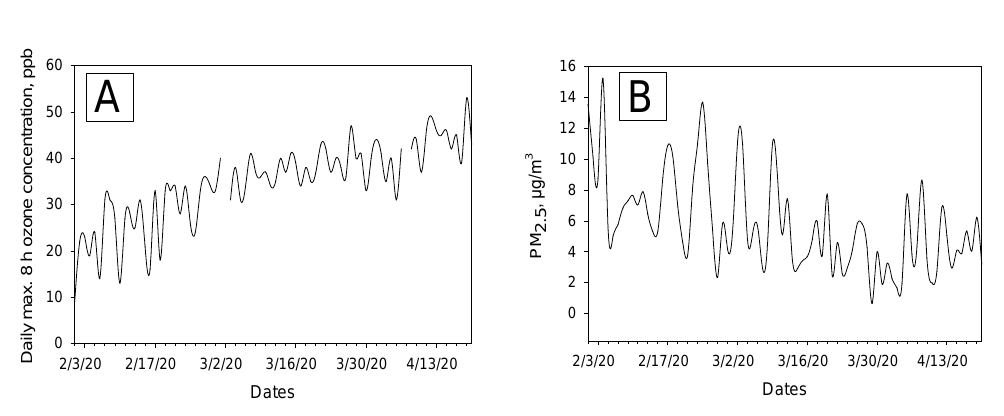
Figure 3. Daily variations of ozone (A) and PM 2.5 (B) in Queens, New York between 1 February and